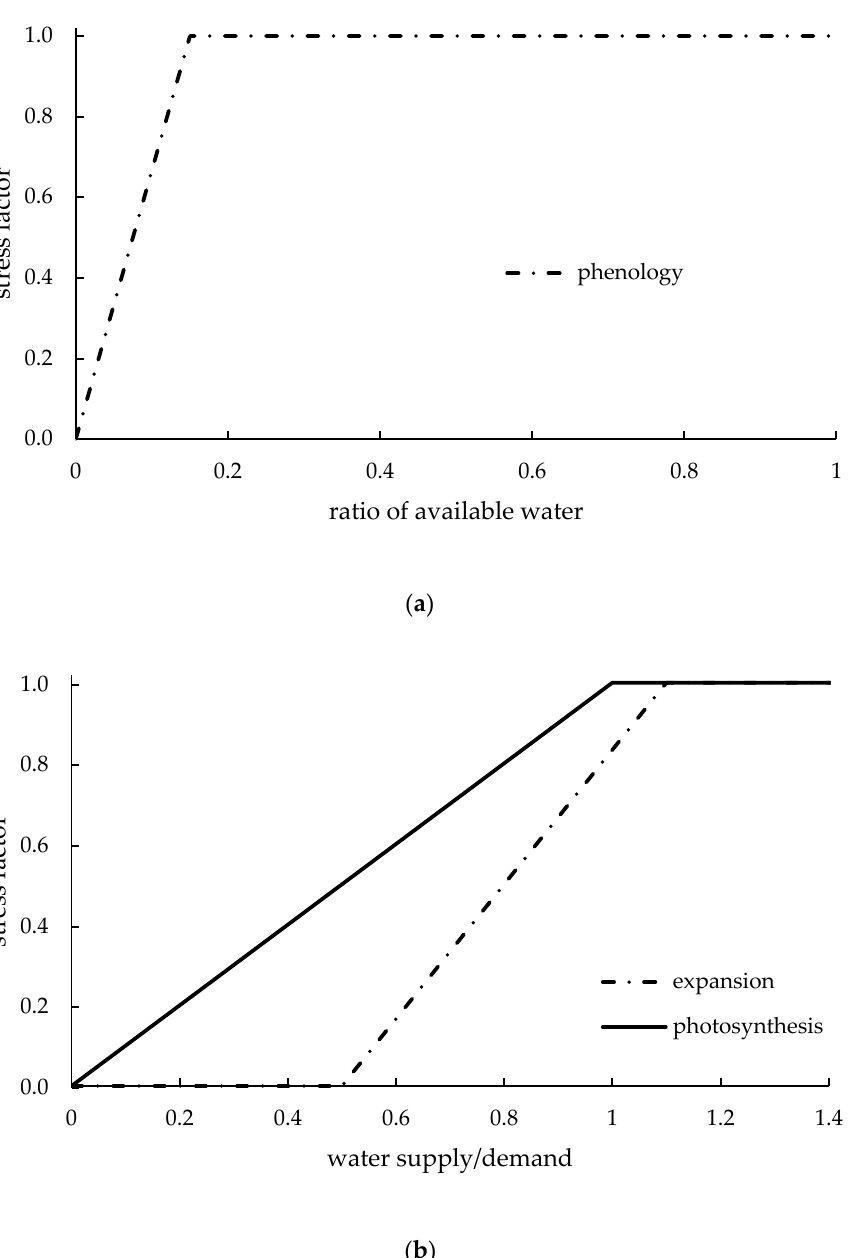
Figure 6. WS coefficients for vegetative growth initially developed for DSSAT (redrawn from Ritchie [51]). The stress is calculated on the ratio between potential root water uptake and potential transpiration. Transpiration and photosynthesis are affected when RWUp/Tp drops below 1, leaf expansion is affected when RWUp/Tp drops below 1.5, to account for the greater sensitivity of this process.